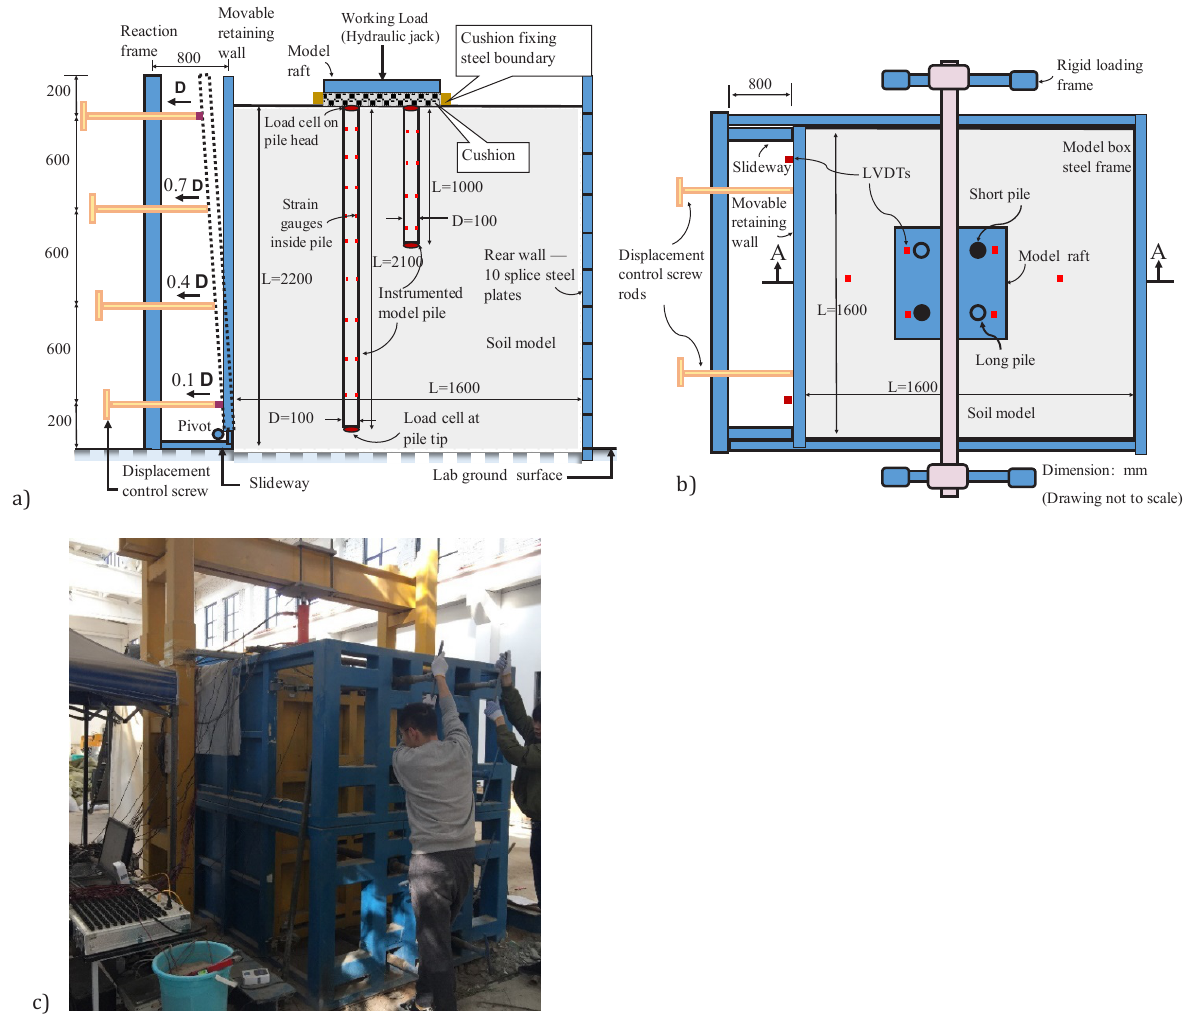
Figure 2 : Schematic view of the test model setup: (a) sectional view, (b) plan view and (c) photograph taken during wall